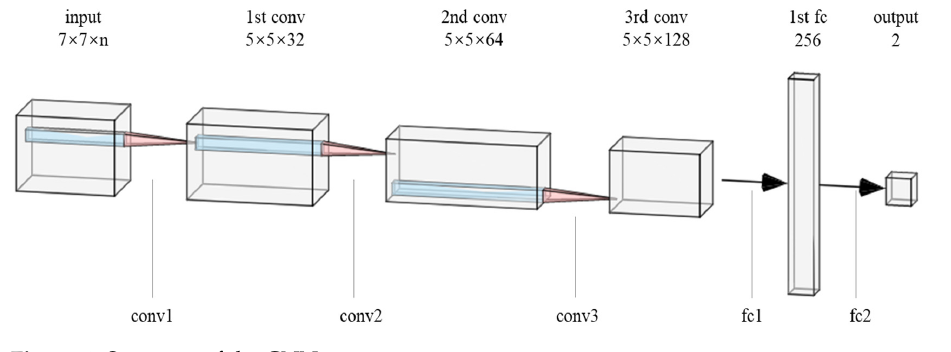
Figure 4. Structure of the CNN. Table 2. Structure of the